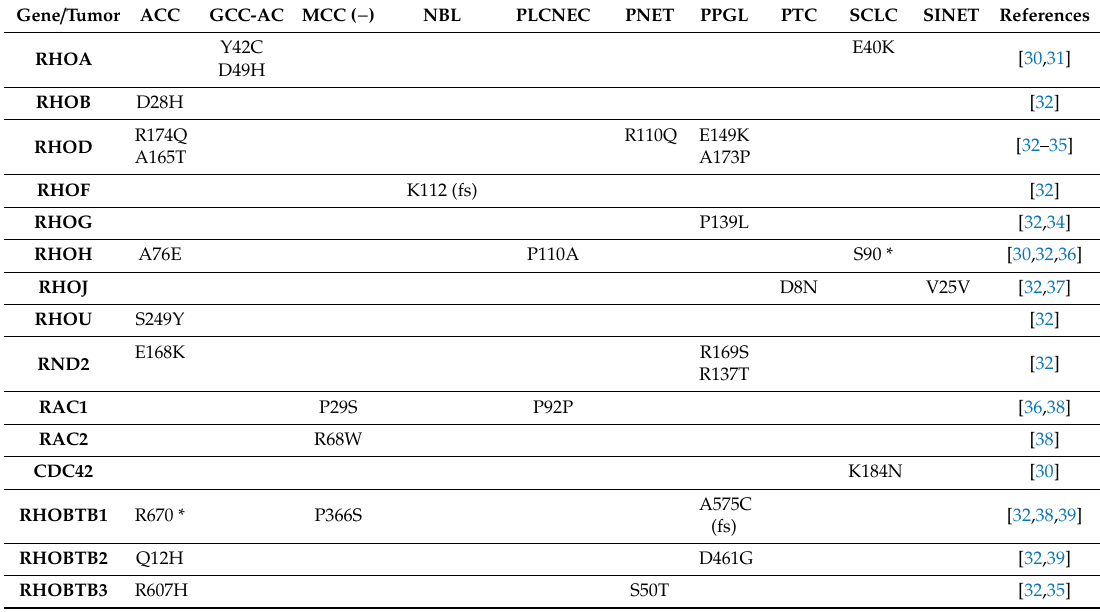
Table 1. Mutations and polymorphisms of Rho GTPases in